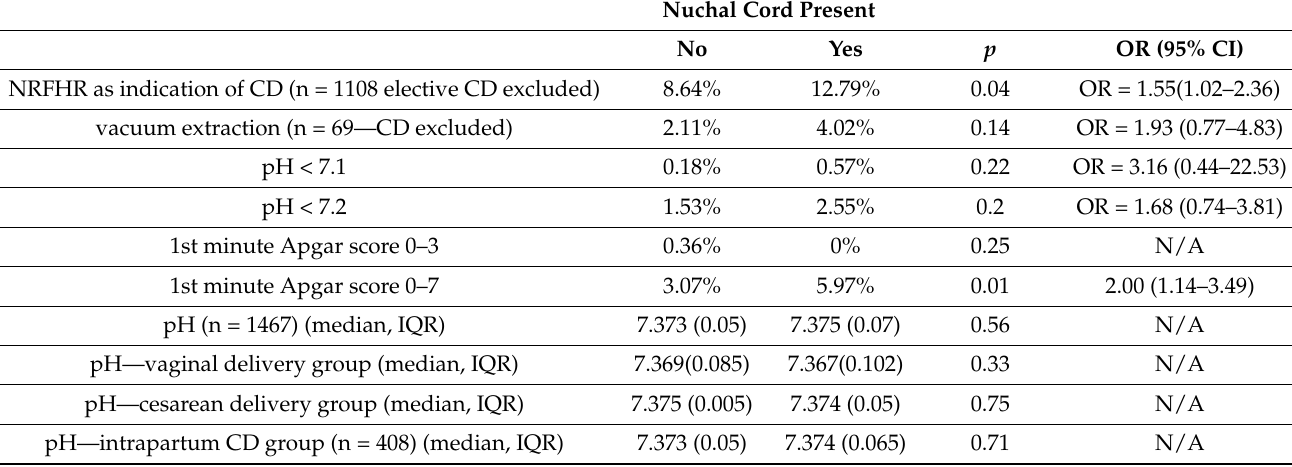
Table 3. The risk of specific obstetric and neonatal events depending on the prevalence of nuchal cord. The comparison of the cord blood pH in both groups. [NRFHR—non-reassuring fetal heart rate, CD—caesarean